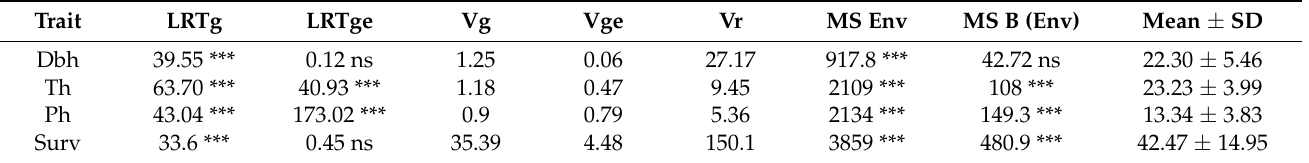
Table 2. The results for random- and fixed-effects of the four traits of the Norway spruce provenances evaluated at age 49, across